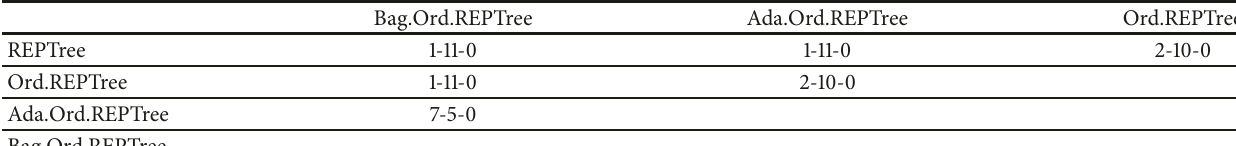
Table 8: The pairwise combinations of the REPTree algorithm with ordinal and ensemble learning versions. Bag.Ord.REPTree